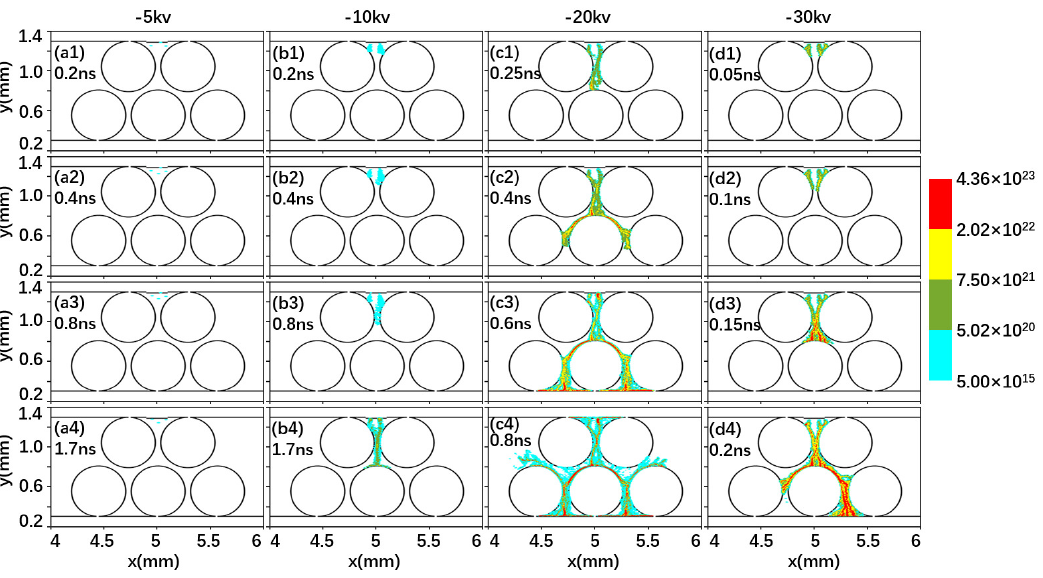
Figure 4. O − ion density (m − 3 ) for the same conditions as in Figure 1. 2